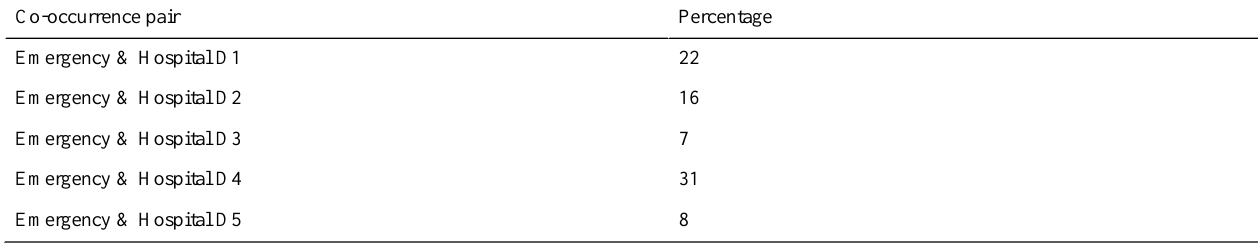
Table 5. Co-occurrence ratios in negatively opinionated threads (Daegu